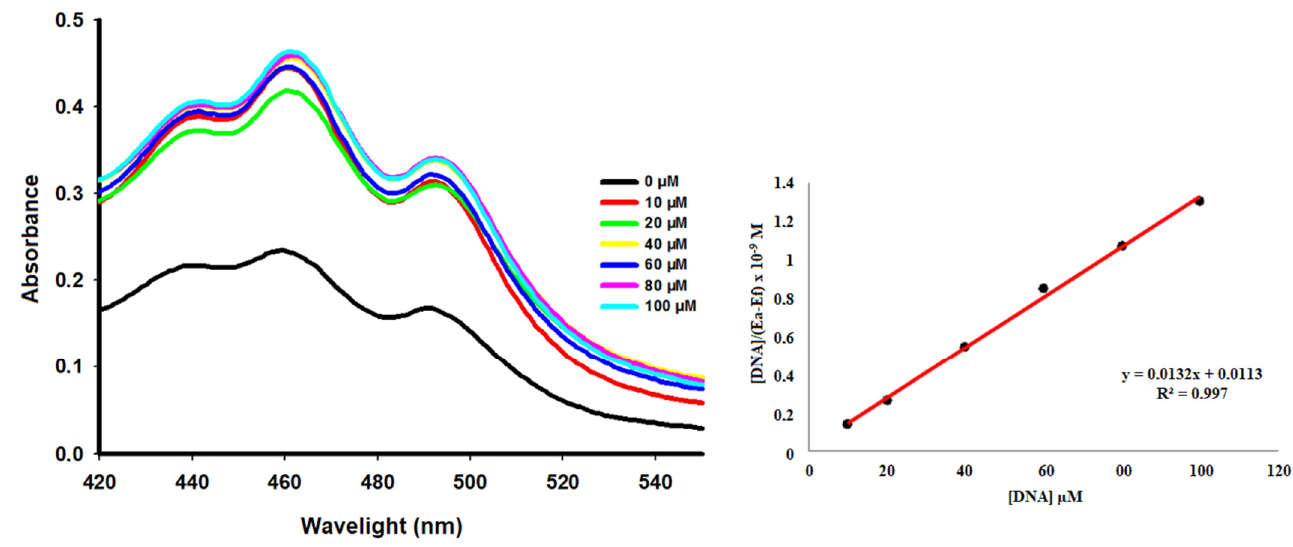
Figure 5. Absorption spectrum (10 µM) in the absence and presence of increasing amount of ACW-